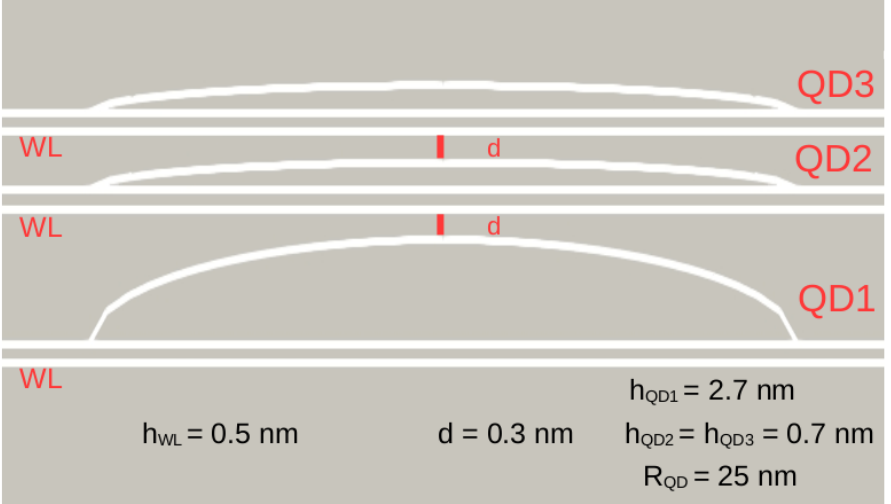
Figure 2. Model of the simulated structure with all geometric parameters.